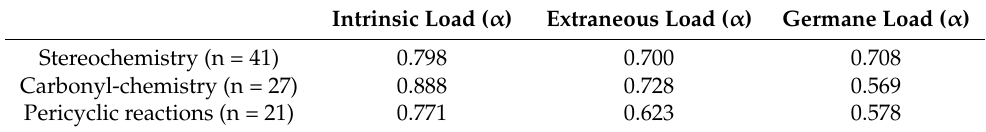
Table 1. Reliability analysis of the cognitive load items.